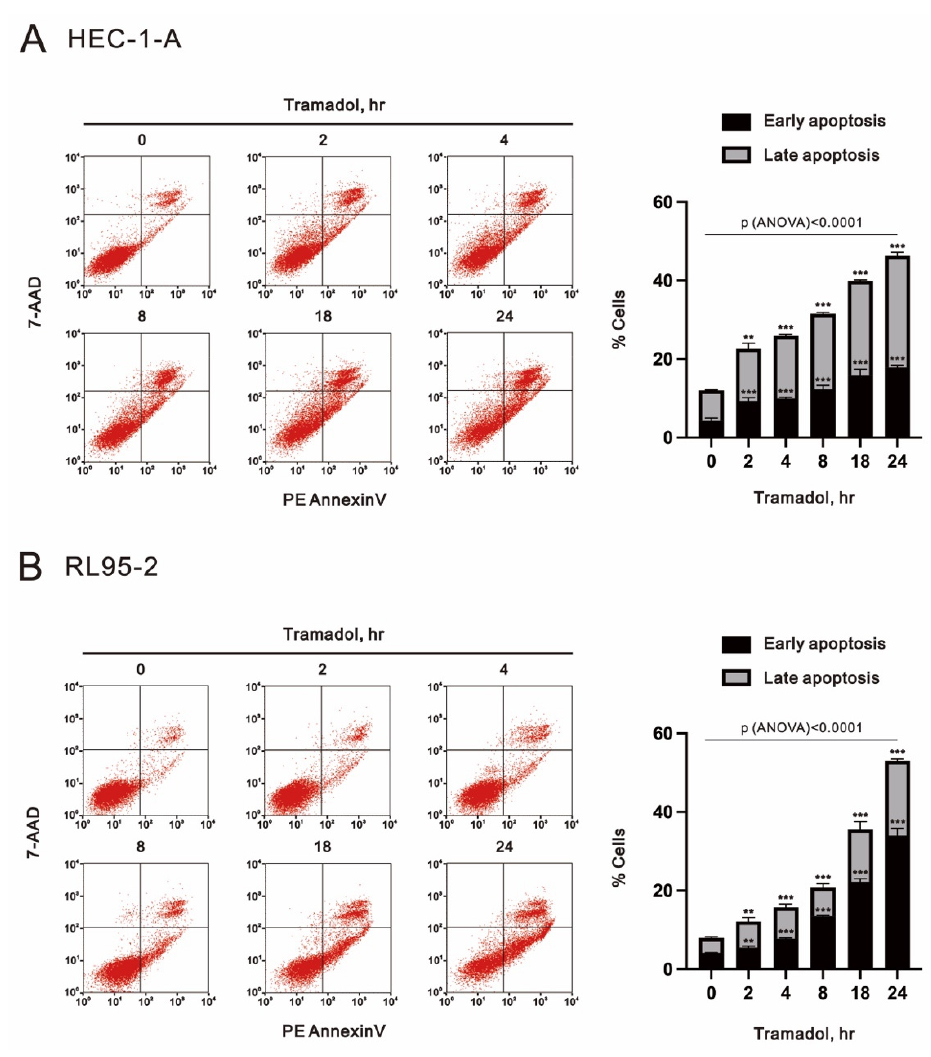
Figure 3. Time-course effects of tramadol on apoptosis in human endometrial carcinoma cells. ( A , B ) HEC-1-A and RL95-2 cells were treated with 1 mg/mL tramadol for 0, 2, 4, 8, 18, and 24 h. Black bars represent the proportion of early apoptotic cells, and gray bars represent the proportion of late apoptotic cells. Bars depict the mean ± SD of three independent experiments. Student’s t -tests were performed, and the results were compared with the vehicle. ** p < 0.01, and *** p < 0.001